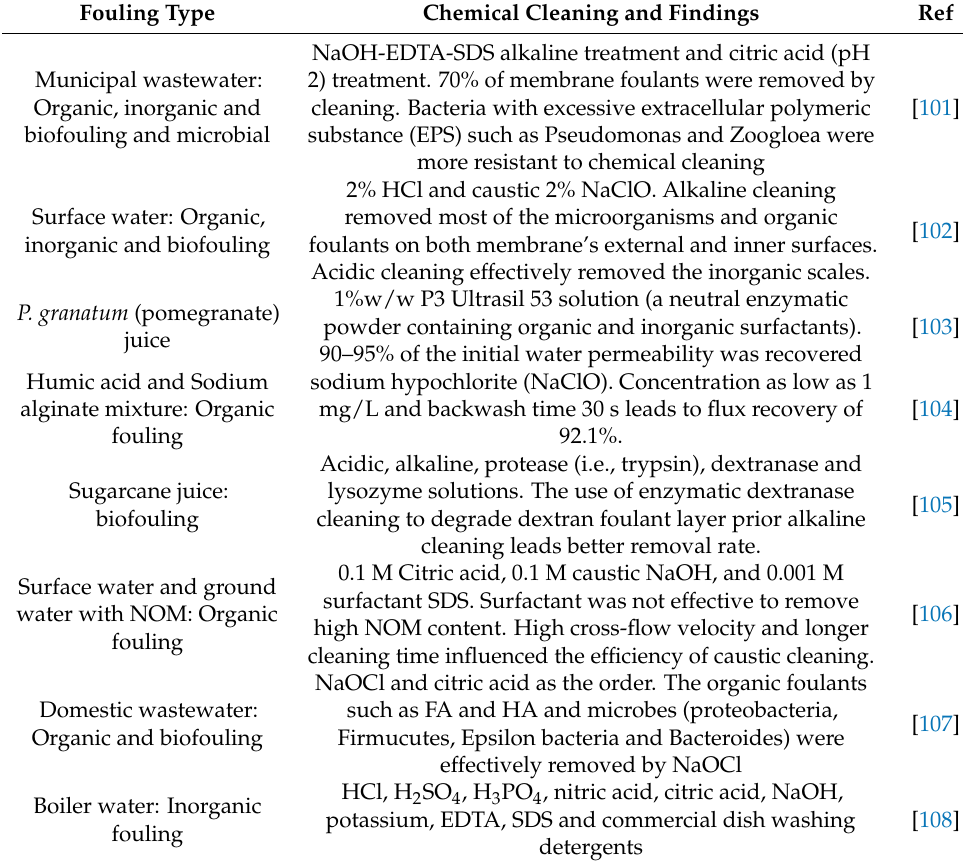
Table 1. Chemical cleaning for various types of